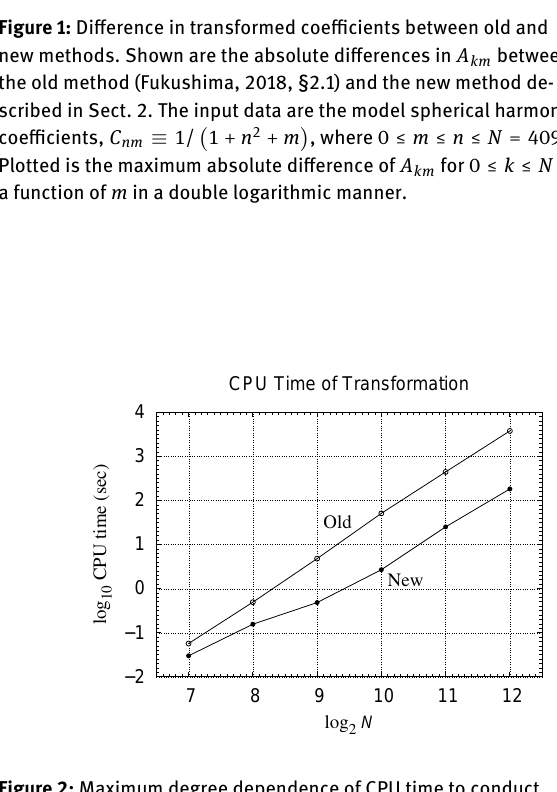
Figure 2: Maximum degree dependence of CPU time to conduct (cid:16) (cid:17) transformation from to ( A km , B km ) . Displayed are the C nm , S nm CPU times to execute the transformation from the given surface (cid:16) (cid:17) spherical harmonic coefficients, , to the corresponding C nm , S nm Fourier series coefficients on the sphere, ( A km , B km ) . The CPU times are measured at a consumer PC with an Intel Core i7-4600U CPU running at 2.10 GHz clock by allowing its 2 cores and 4 threads fully employed. Compared are the computation using the old scheme (Fukushima, 2018, §2.1) and that by the new method. Both of them are roughly in proportional to N 3 , where N is the maximum degree/order of the spherical harmonic coefficients to be trans- formed. However, the proportional coefficients are significantly different, say a factor of 20 or more when N ≥ 2 10 = 1, 024 , such that the new method is significantly